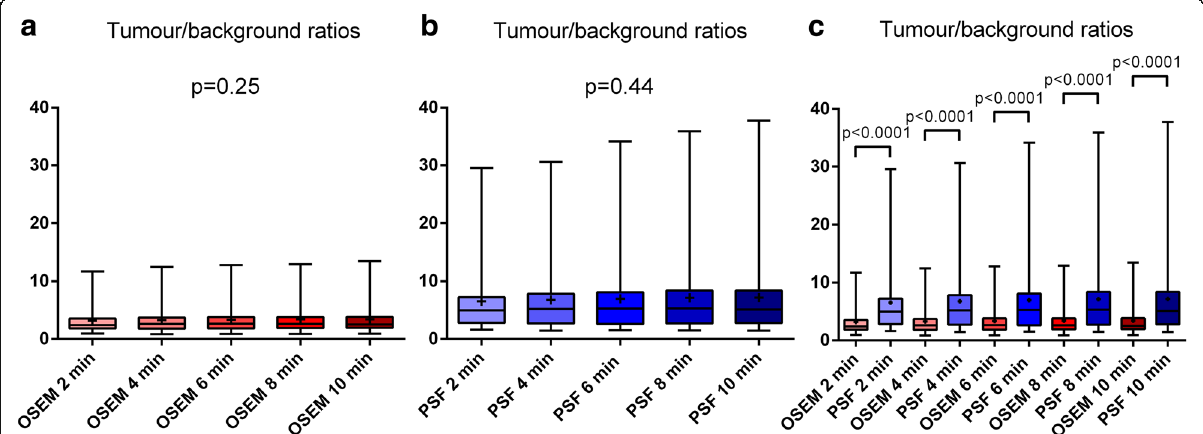
Fig. 2 Comparison of the tumour/background ratios (TBRs) in 3D-OSEM-reconstructed ( a ) and PSF allpass -reconstructed ( b ) head-and-neck (HN) PET data sets for each of the five acquisition times per bed position from 2 to 10 min with a 2-min increment. c Comparison of the TBRs between 3D-OSEM and PSF allpass -reconstructed HN PET data sets